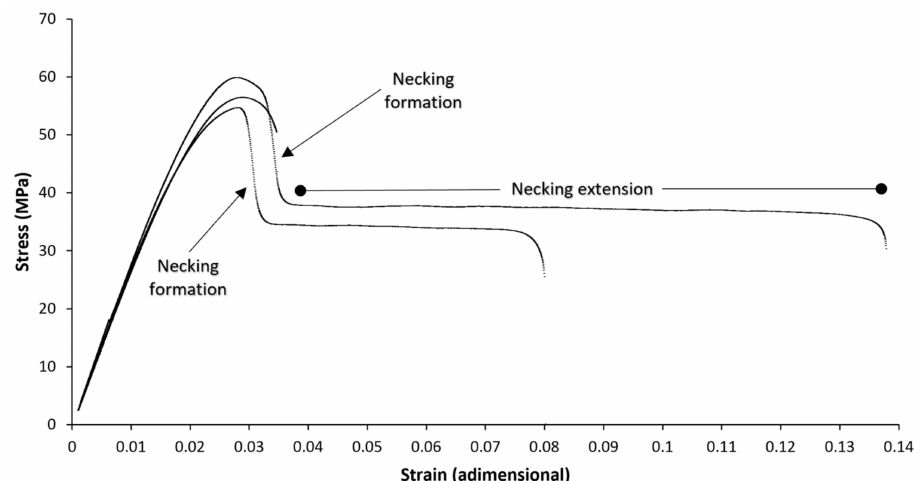
Figure 14. Example of tensile tests with and without necking formation. Notice the long strain for some necking extensions, which has induced considerable standard deviations in the average elongation at break.